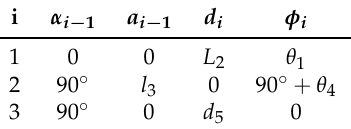
Table 2. DH parameters of P 2 .